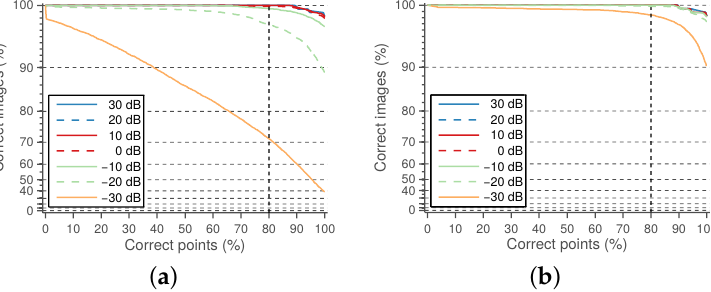
Figure 7. Performance of the candidate lumen detection algorithm as a percentage of images with the correct candidate depending on the percentage of correct points of the candidate. ( a ) With added Gaussian noise; ( b ) with added speckle noise. The curves corresponding to SNRs under 0 dB are mostly